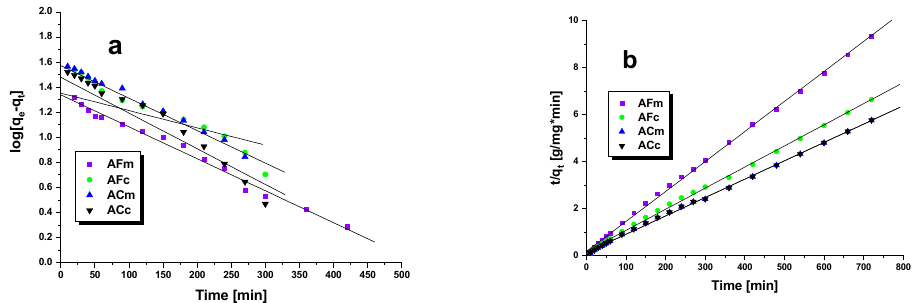
Figure 6. Pseudo-first-order ( a ) and pseudo-second-order ( b ) kinetic plots for adsorption of methyl red sodium salt onto biocarbons.